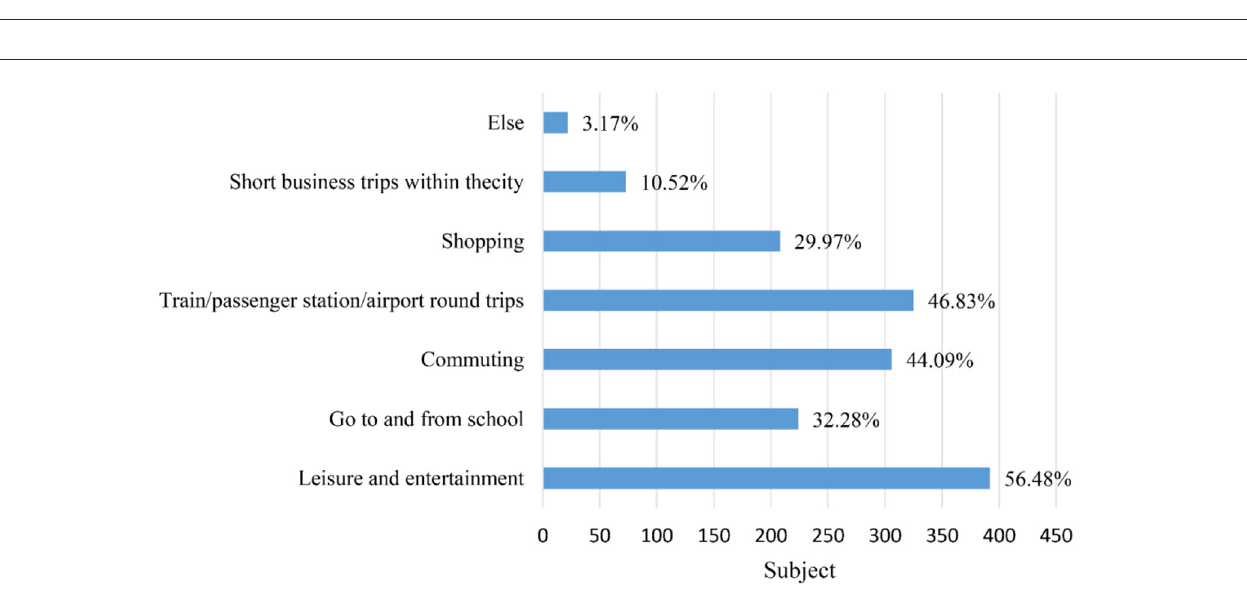
FIGURE5 Purpose of travel before the epidemic.